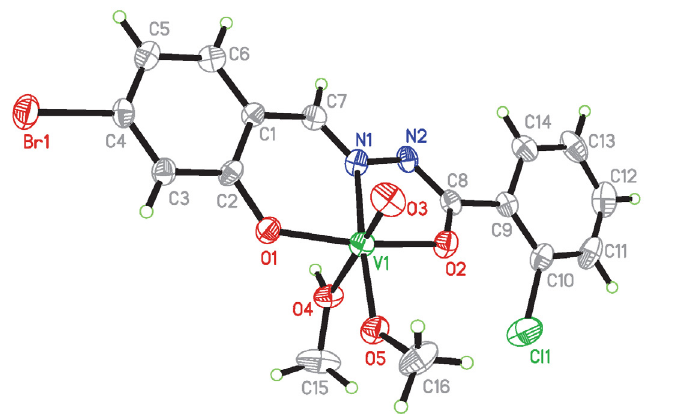
Figure 3. A perspective view of complex 1 with the atom labeling scheme. Thermal ellipsoids are drawn at the 30% probability